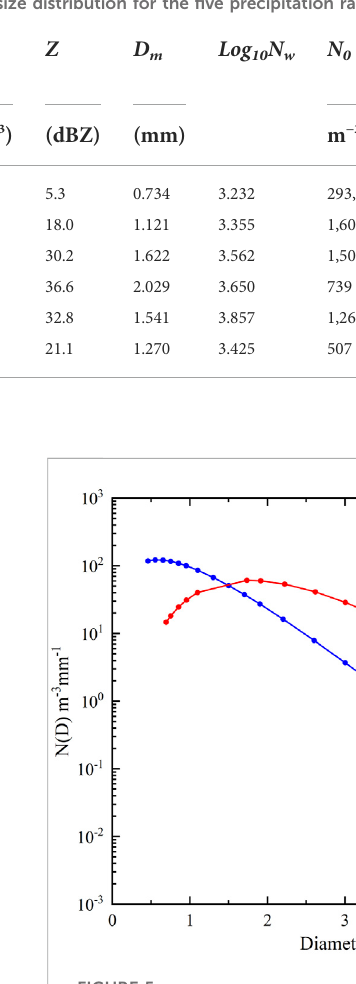
FIGURE 5 Averageraindropsizespectraforthestratiform(blueline)and convective (red line) precipitation types in the head watershed of the Urumqi River